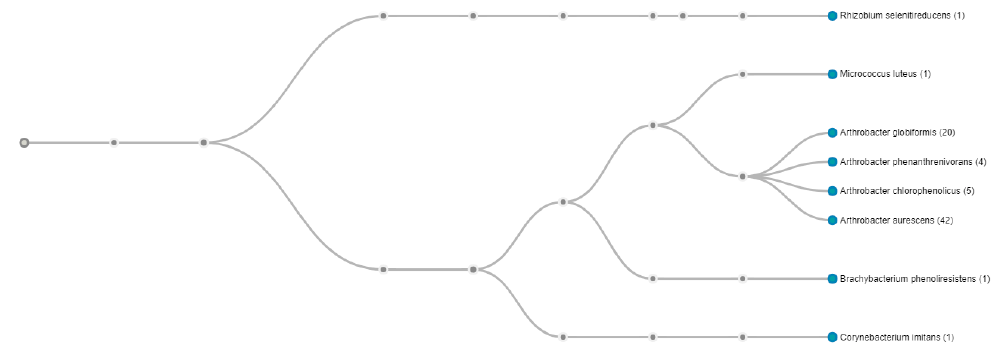
Figure 3. Whole genome sequence-based phylotree of Arthrobacter sp. strain SRS-W-2-2016 relative to a cohort of 24 Arthrobacter spp., for which genome sequences are available. The highest taxonomic affiliation of strain was found with Arthrobacter aurescens TC1 based on the highest number of whole genome sequence reads (42; shown in parenthesis) that clustered with this group. The tree was generated based on the presence of the Pfam function category amongst Arthrobacter spp. available in the integrated microbial genome expert review (IMG/er) database. Displayed nodes are those with at least one read (<1% of classified reads).